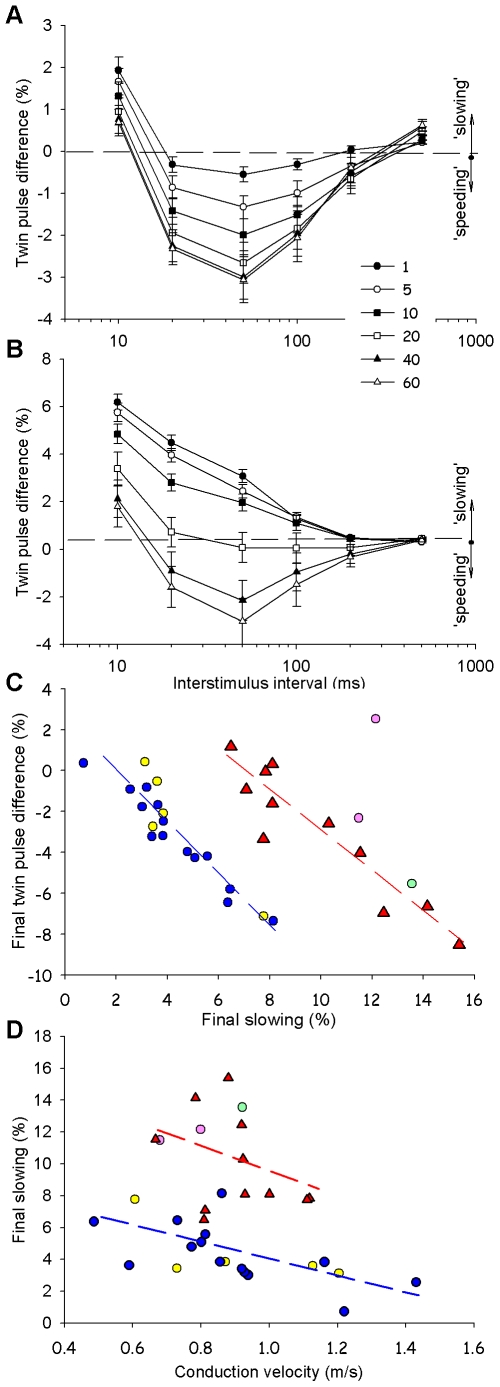
Mechanically-sensitive afferents and presumed sympathetic efferents exhibit different twin pulse speeding and activity-dependent slowing during the repeated twin-pulse paradigm.
A) Presumed sympathetic efferents. The twin-pulse latency difference is plotted versus stimulus interval for the 1st, 5th, 10th, 20th, 40th and 60th twin stimulus. Twin pulse speeding is observed for ISIs between 20 and 100 ms. The amount of twin pulse speeding increases during the repeated paradigm (n = 13–20, except at the 1st twin pulse at 50 ms where n = 32). B) Mechanically-sensitive afferents. For the first twin pulse, twin pulse slowing is observed over all ISIs. After 20 twin pulses, speeding develops over a range of ISIs from 20 to 100 ms. (n = 7–12, except at the 1st twin pulse at 50 ms where n = 46). C) The plot of final twin pulse difference versus final slowing reveals two non-overlapping clusters corresponding to the presumed sympathetic efferents and the afferents. Presumed sympathetic efferents and afferents exhibited a similar range of twin-pulse speeding by the final (60th) twin pulse of the repeated twin pulse protocol. The final activity-dependent slowing (i.e., increase in latency of the first AP in the last twin-pulse relative to the latency of the first AP in the train) was greater in the sympathetics than the afferents. One mechanically-insensitive fiber (green circle) not tested with chemicals behaved like an afferent. Only data from twin pulses separated by 50 ms are included. Symbol coding same as in Fig. 3C. D) Correlation of the final slowing and conduction velocity. The final slowing tends to decrease as the conduction velocity increases for both classes of fibers. Mechanically-sensitive afferents and presumed sympathetic efferents form distinct clusters. Note that the green circle is again within the afferent cluster and presumably a mechanically-insensitive afferent. All data in this figure were obtained in centripetal recordings.